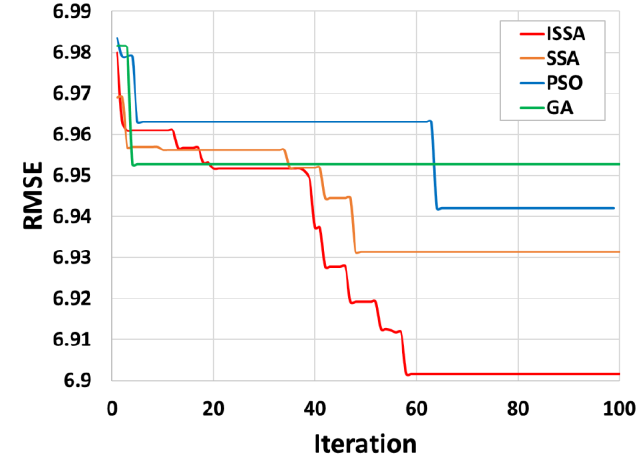
Figure 7. Error reduction rate in various iterations of the optimization algorithms (ISSA, SSA, PSO, and GA) for training DELM using Well M.